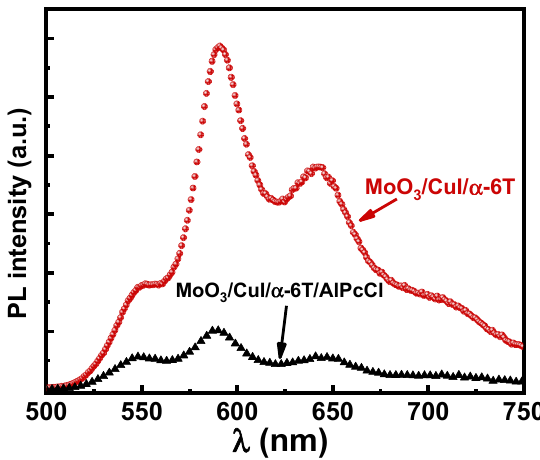
Figure 5. Photoluminescence spectrum of a α -6T layer alone ( ● ) and covered by AlPcCl ( ▲ ). At room temperature, the emission spectra of α -6T consists of three bands located at 2.25 eV, 2.10 eV, and 1.92 eV, which is in excellent agreement with the literature [38]. The most energetic emission peak, located at 2.25 eV, is identified as the 0-0 excitonic transition, which is located at 2.27 eV; the others are generally attributed to vibronic coupling. We also carried out the carrier mobility measurements of the different organic layers.